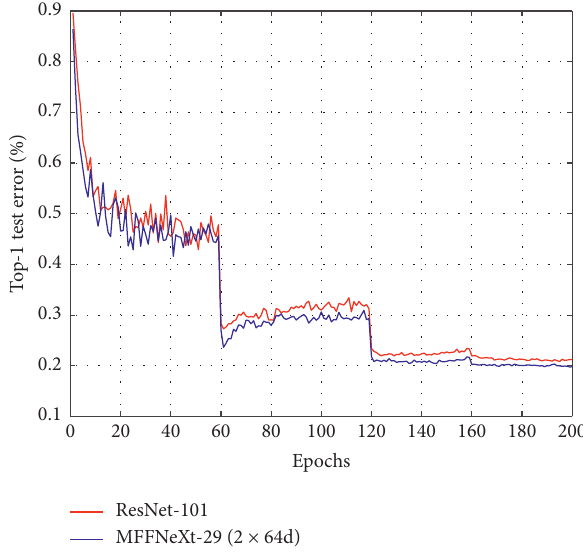
Figure 7: Top-1 testing error rate versus number of epochs for CIFAR-100. The numbers of parameters for ResNet-101 and MFFNeXt-29 (2c × 64) are 42.70M and 9.37 M,